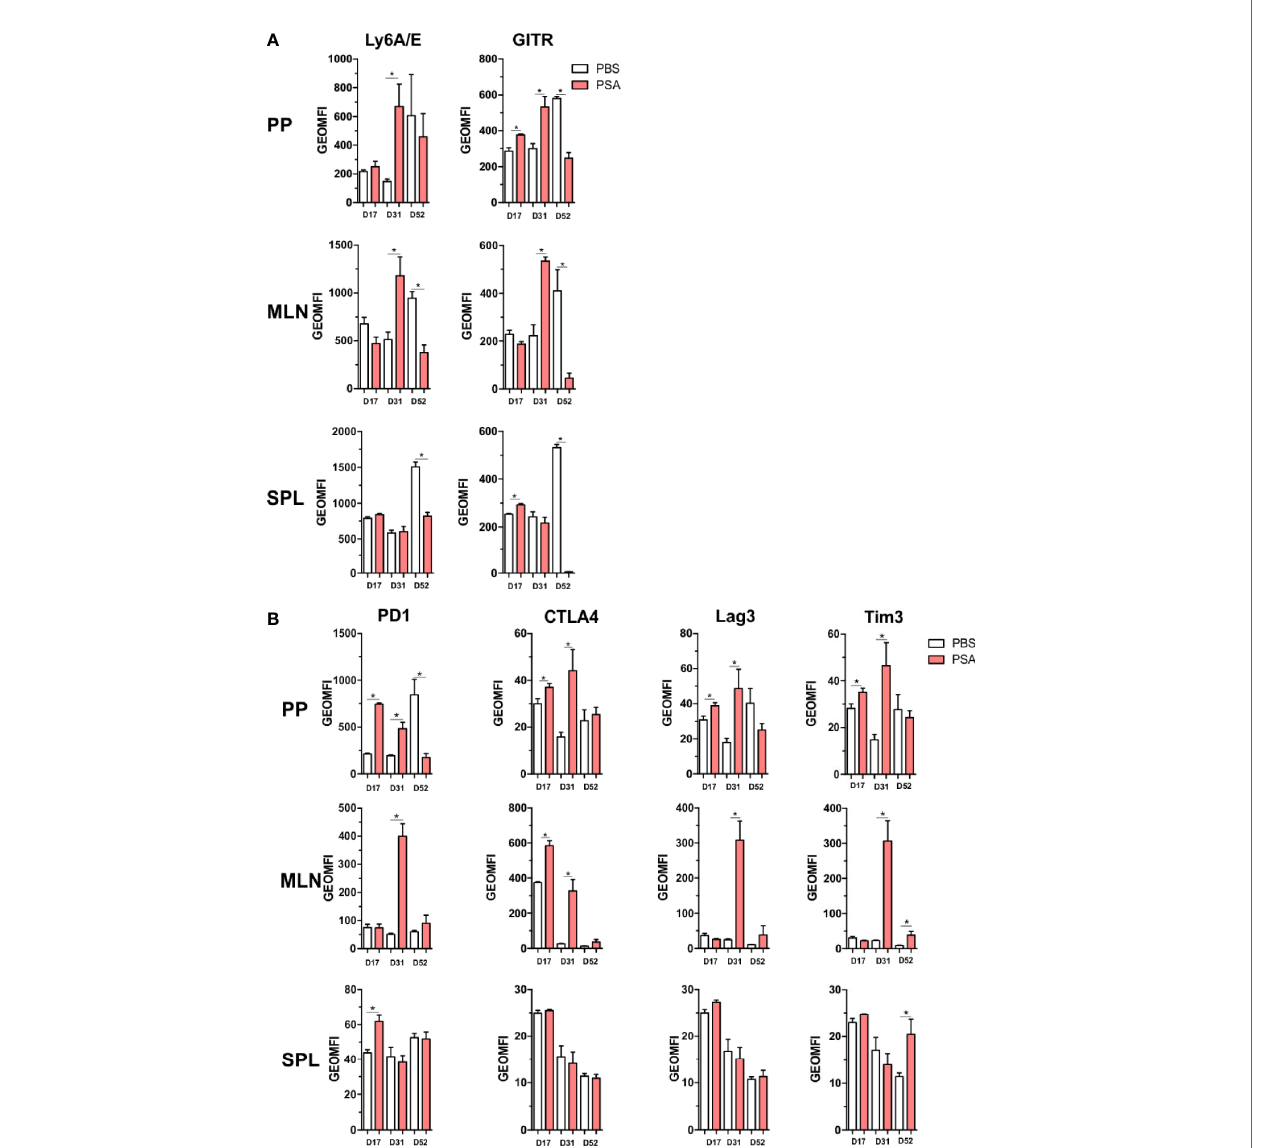
FIGURE 7 | Gut associated lymphoid tissue enrichment of PSA induced markers. Mice were orally gavaged with 100 µg of PSA dissolved in PBS every 72 h, 5 gavages total. Peyer ’ s patches, mesenteric lymph nodes and spleens were collected on D17, D31 or D52 after initial gavage. Data is geometric MFI. (A) In vivo activation marker expression across organs and time points. (B) Expression pro fi le of immunomodulatory markers across organs and time points. (n = 3 mice per group, signi fi cance of P ≤ 0.05 =